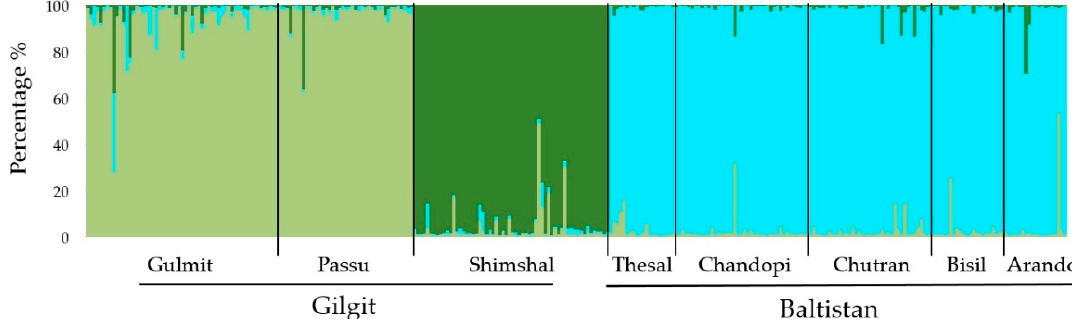
Figure 6. Bayesian inference of the most likely number of clusters ( K = 3) of sea buckthorn sampled in the Gilgit and Baltistan regions, northern Pakistan. Three colors in vertical individual bars reflect the likelihood of individual genotypes to belong to one of the three clusters, respectively.